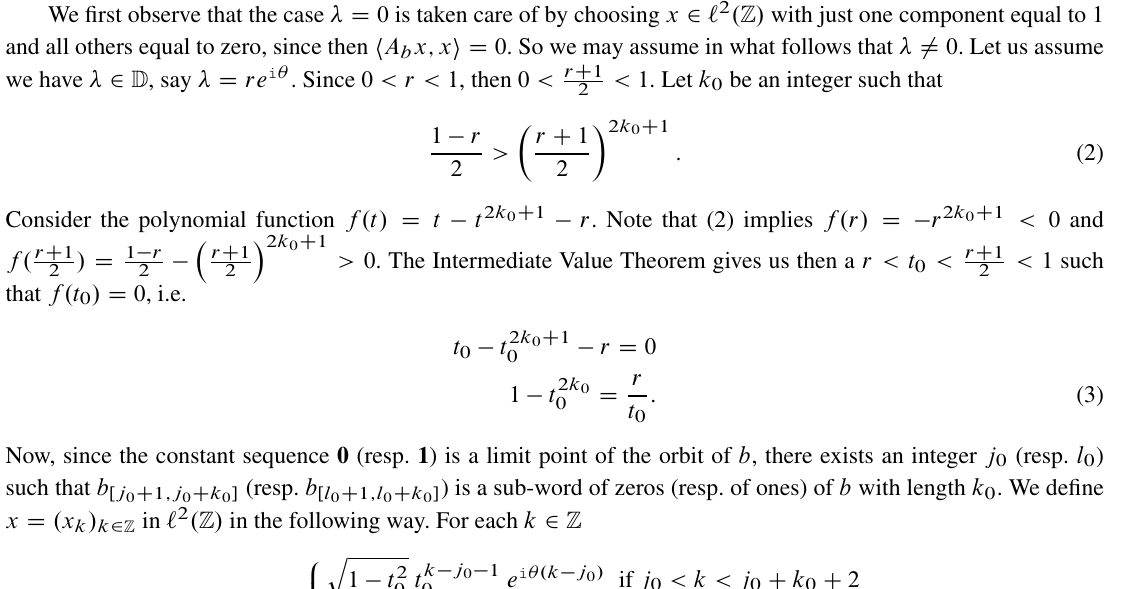
Using j 2 Re .(cid:21)/ j D j 2r cos (cid:18) j (cid:20) j 2r cos .(cid:25)=3/ j D r D j (cid:21) j and again that j (cid:21) (cid:0) 2 Re .(cid:21)/ j D j (cid:21) j , we